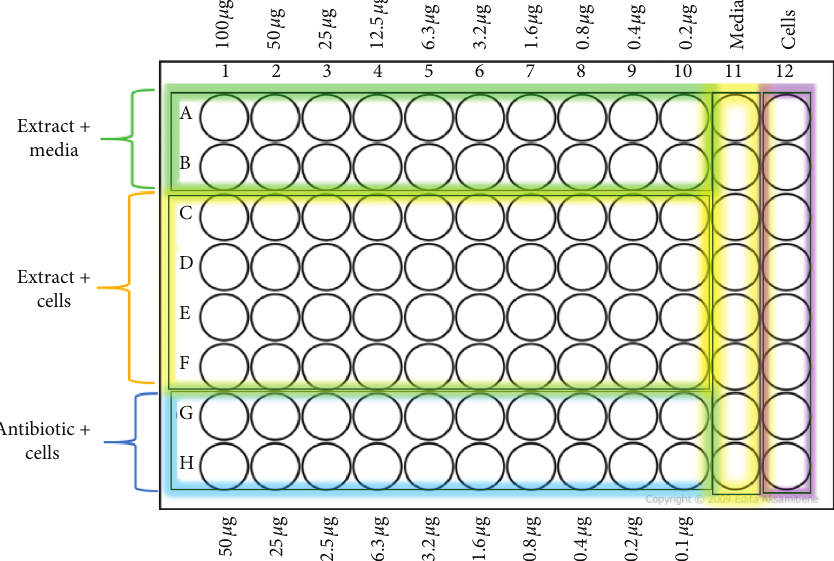
Figure 1: Plate setup for 2-(4-iodophenyl)-3-(4-nitrophenyl)-5-phenyl-2H-tetrazolium chloride (INT) colorimetric assay for minimum inhibitory concentrations (MIC). The “cells” column is the positive control for microbial growth (cells were inoculated in untreated broth media). The “media” column is the negative control for cell growth (wells contained uninoculated broth media). The “antibiotic+ cells” rows are the antibiotic/antifungal positive control (cells were inoculated in wells with decreasing standard antimicrobial/antifungal concen- tration). The “extract+ cells” rows are the test wells (cells were inoculated in wells with decreasing extracts